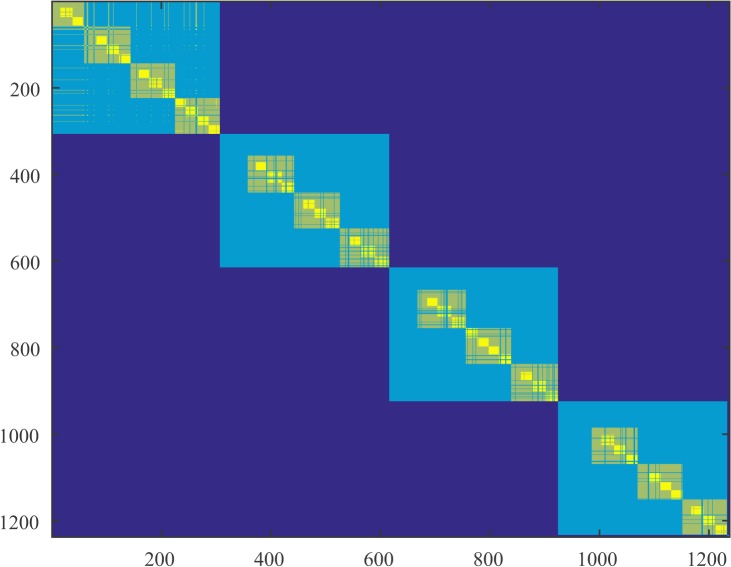
Modified co-affinity matrix during question.Modified co-affinity matrix for subject 1 during the segment that the subject was exposed to a question. We display only the first 1200 vertices. The lighter the color, the higher the probability two nodes belong to the same cluster over all the regularity partitions obtained by our algorithm, i.e., partitions with decreased modularity. Nodes were labeled properly such that the weight in the diagonal is higher using an optimization algorithm.